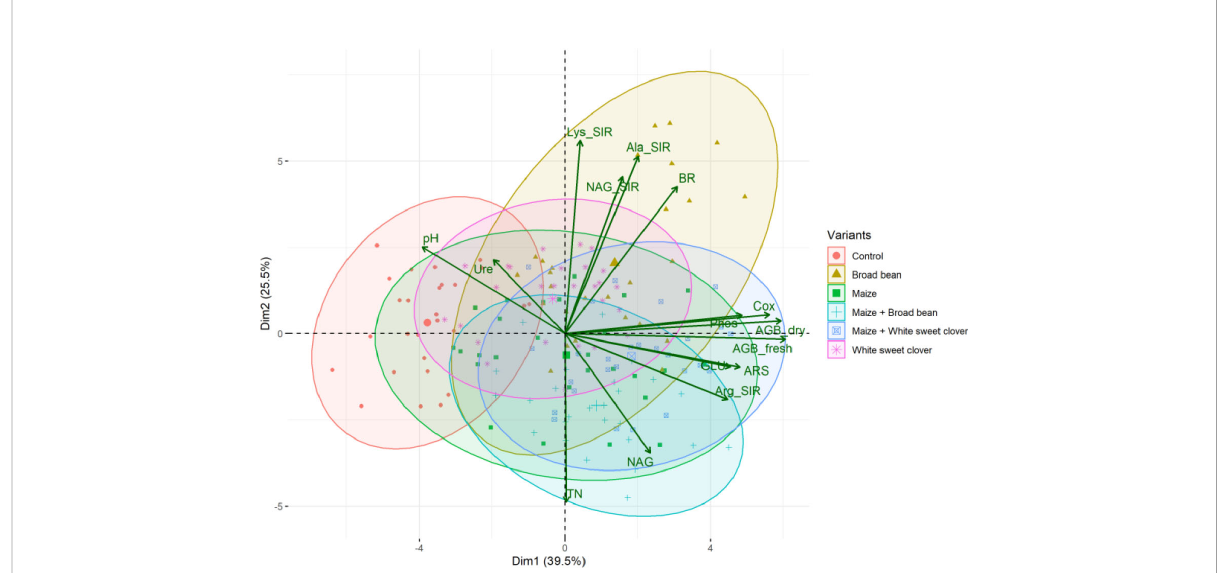
FIGURE 3 PCA biplot of relationships between soil and plant properties of all variants. Fresh (AGB_fresh) and dry (AGB_dry) aboveground plant biomass, soil pH, total nitrogen (TN), total oxidizable carbon (Cox), basal (BR), and substrate-induced respirations - N-acetyl- b -D-glucosamine (NAG_SIR), L-alanine (Ala_SIR), L-lysine (Lys_SIR), and L-arginine (Arg_SIR); enzyme activities - urease (Ure), arylsulfatase (ARS), N-acetyl- b -D- glucosaminidase (NAG), b -glucosidase (GLU), and phosphatase